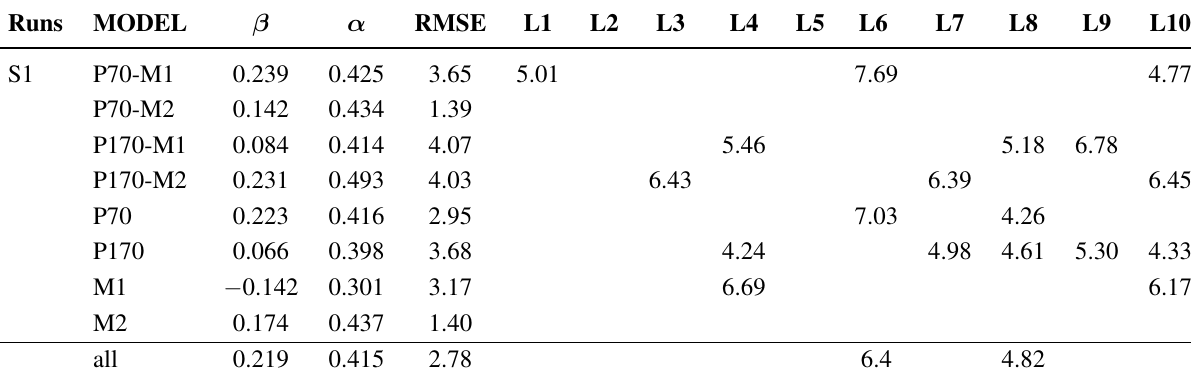
) calc ) are shown as well, together with exp